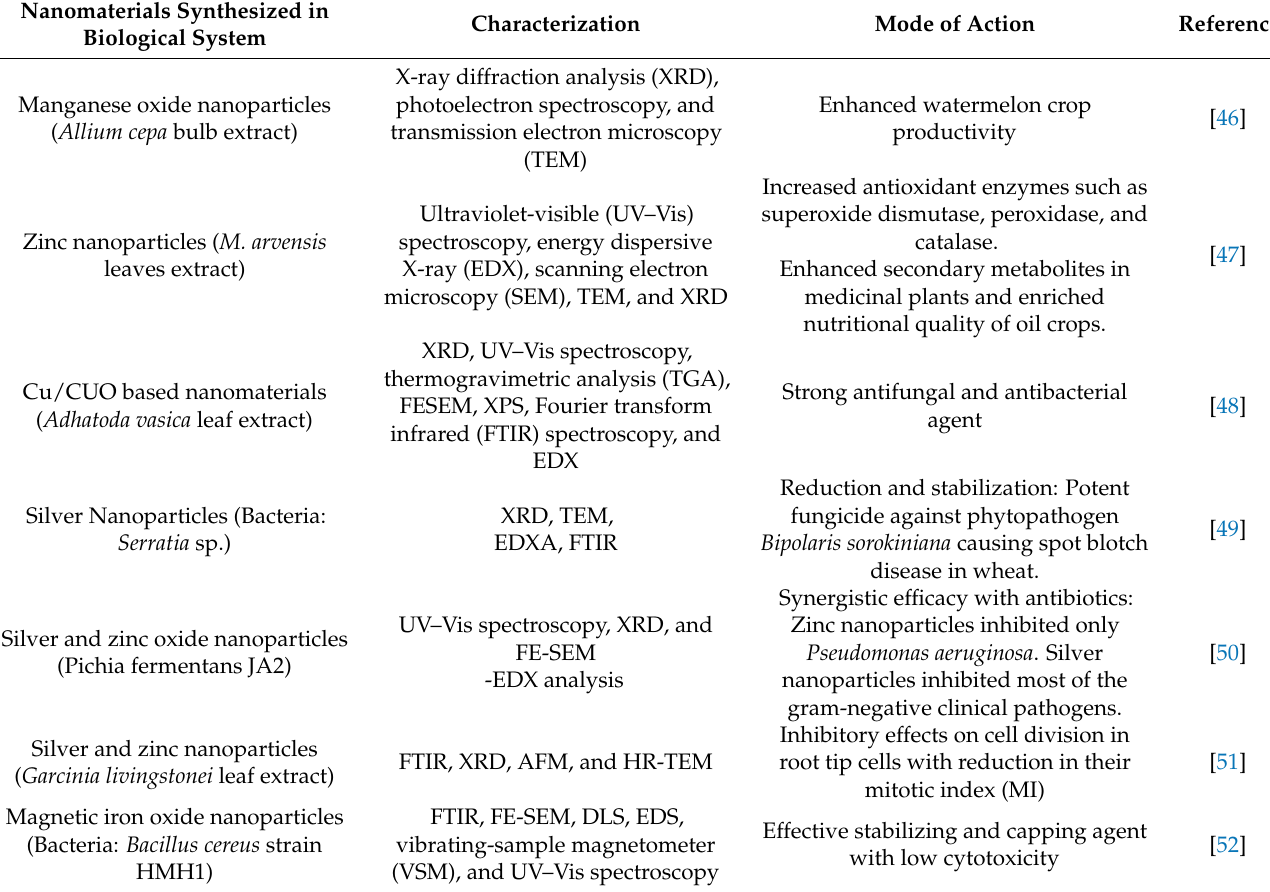
Table 1. Potential biosynthesized nanomaterials in food packaging and